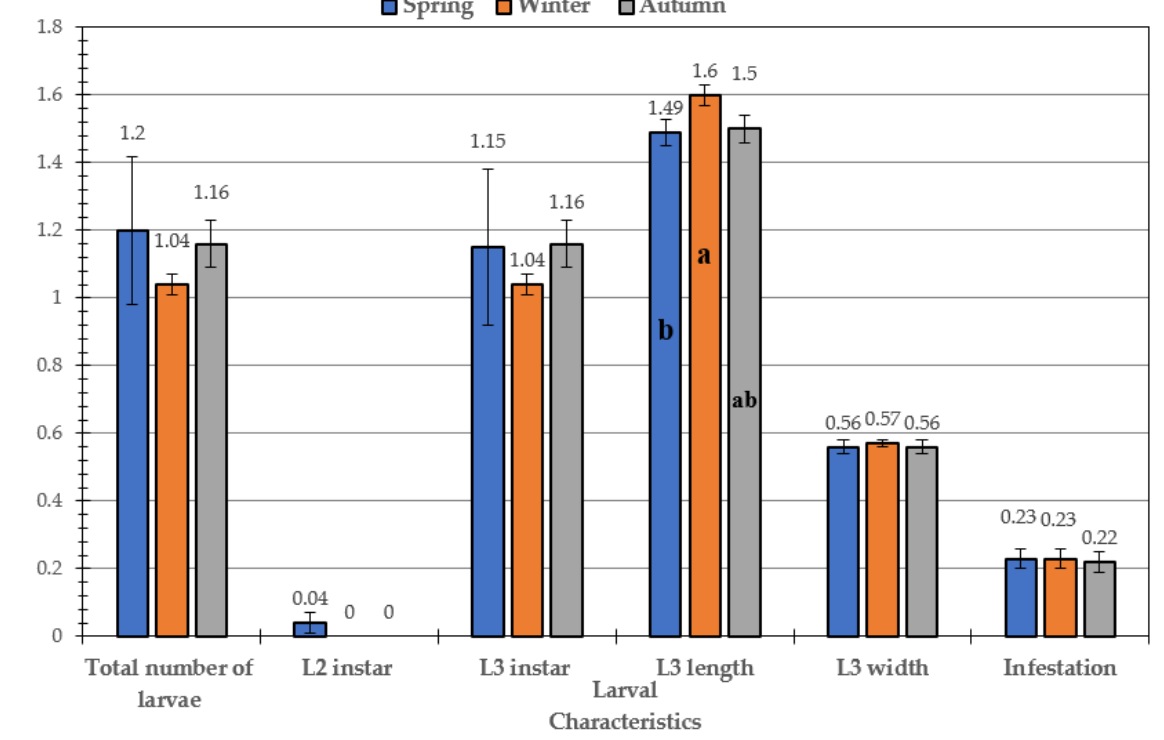
Figure 2. Effect of seasons on larval characteristics in infested sheep. Mean values with different letters (a and b) are significantly different at p ≤ 0.05 between seasons.